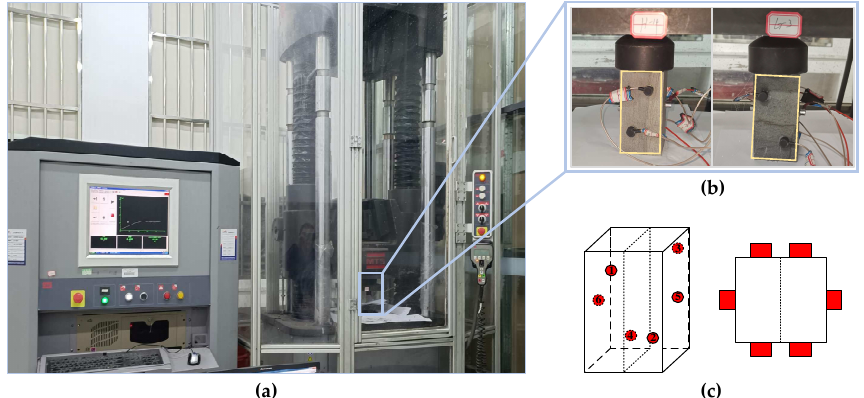
Figure 4. Test equipment and scheme: ( a ) MTS electrohydraulic servo testing machine; ( b ) uniaxial compression test; ( c ) diagram of acoustic emission (AE) probe arrangement. Table 2. Composition of clay minerals.